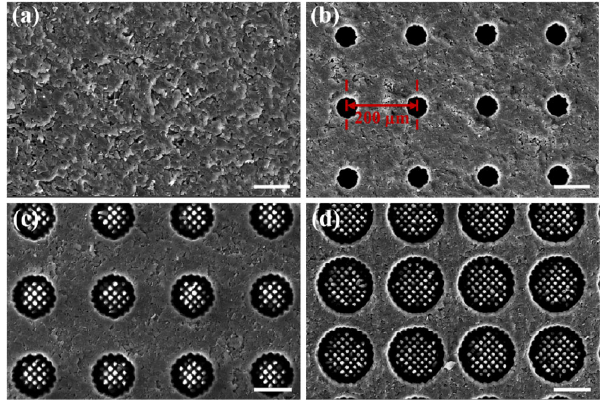
Fig. 2 (a) Surface morphology (scale bar: 100 µm) of PPI, (b) HPPI-T50, (c) HPPI-T100, and (d) HPPI-T150.